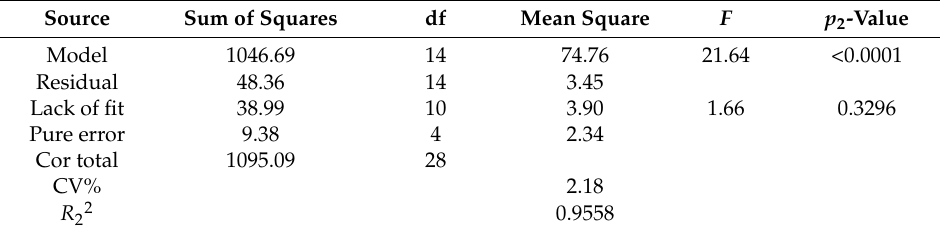
Table 4. The variance analysis of the fitted quadratic polynomial prediction model of P.